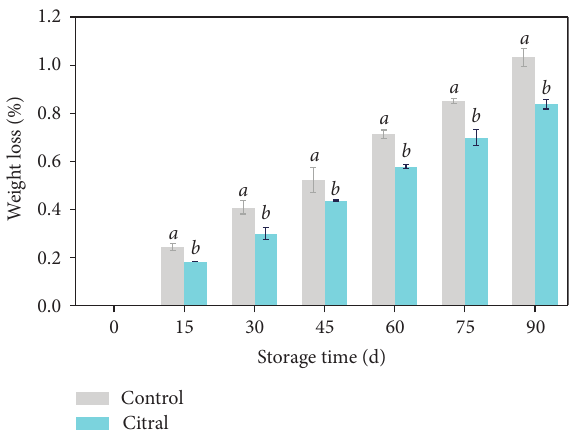
Figure 1: Effect of citral treatment on weight loss of harvested kiwifruit stored at 0-1 ° C for 90d. Vertical bars represent the mean ± standard error (S.E., n � 3). Letters indicate the statistical differences according to the independent samples t -test ( p < 0 . 05) on each storage day.